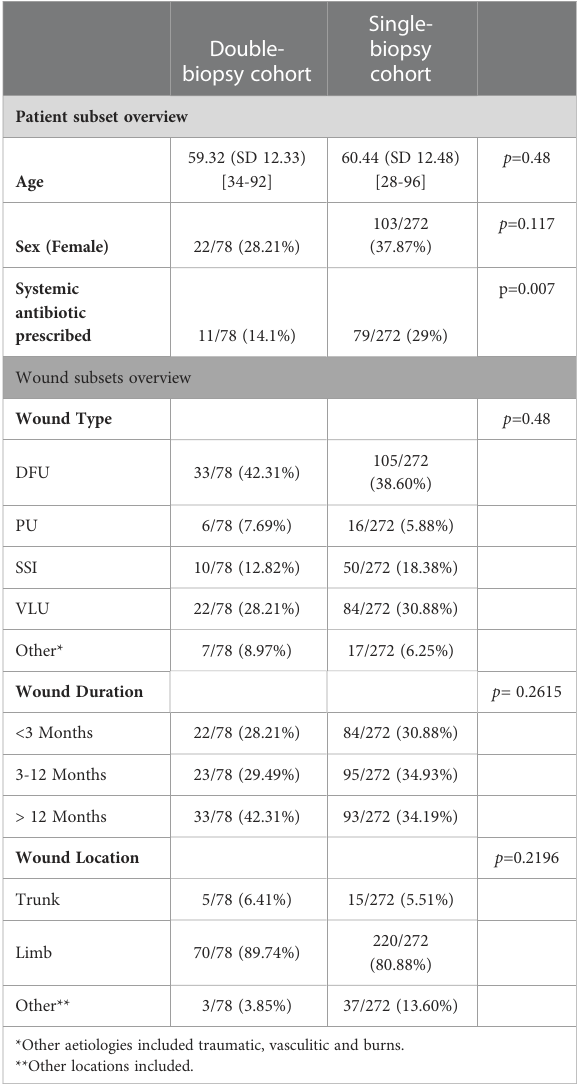
TABLE 1 Comparison of patient and wound characteristics between double-biopsy and single-biopsy cohorts.